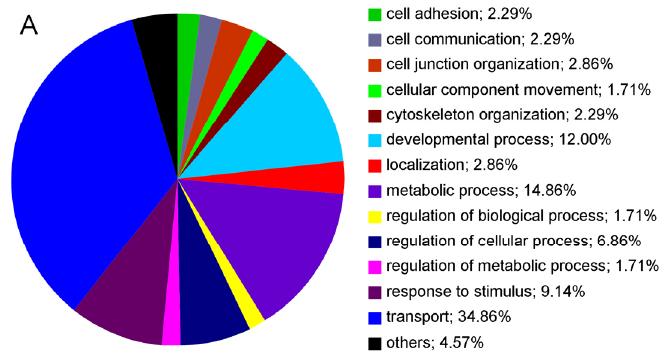
Figure 1. Classification of RPE cell surface proteins based on GO for biological process of native RPE cell proteins ( A ) and passage-4 RPE cell proteins ( B ). Numbers in percentages (%) correspond to the number of GO terms assigned for respective preparation. GO terms defined as others include those with an occurrence of